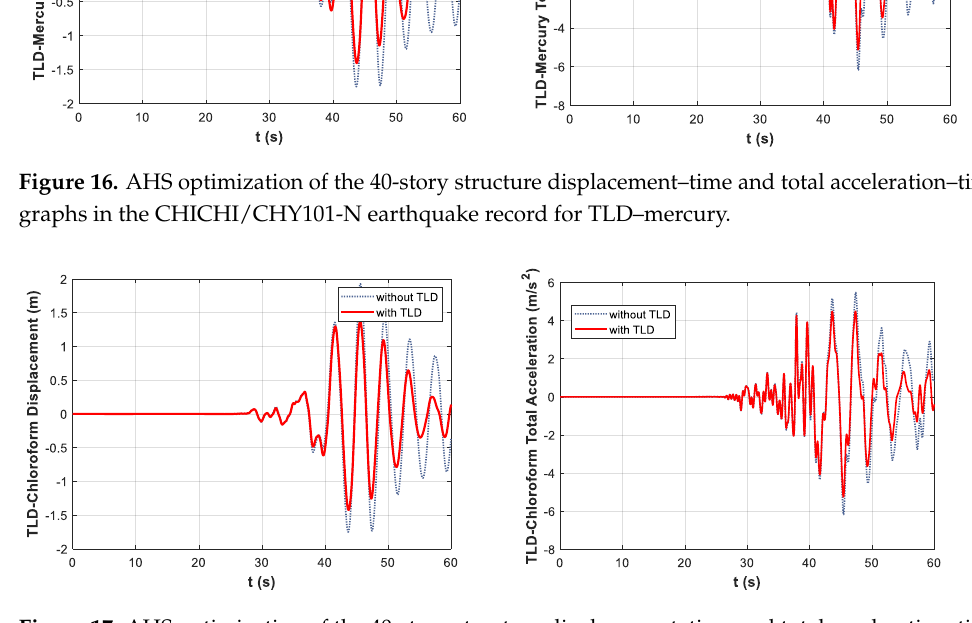
Figure 18. AHS optimization of the 40-story structure displacement – time and total acceleration – time graphs in the CHICHI/CHY101-N earthquake record for TLD – seawater.